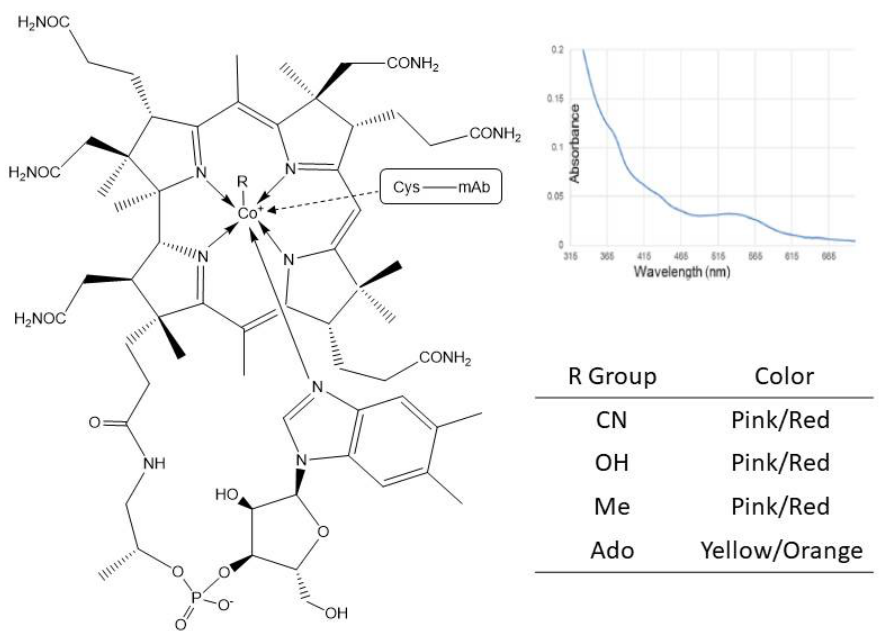
Figure 6. Vitamin B12 structural variants and associated color. (right panel) Absorption spectrum of a purified pink colored mAb preparation. Local maximum at about 365 nm reflects the presence of vitamin B12 (hydroxocobalamin). Reproduced with permission from reference [12].